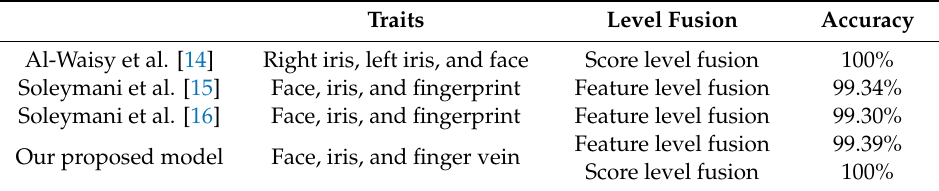
Table 4. Comparison with previous